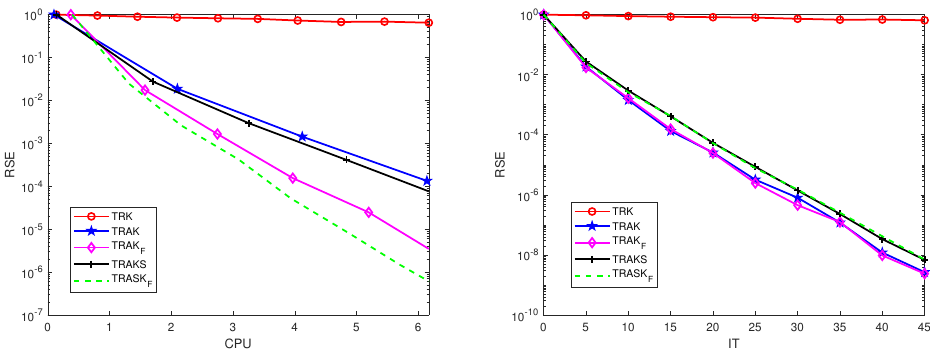
Figure 7. Pictures of the average RSE versus IT and CPU times for the TRK, TRAK, TRAK F , TRAKS, and TRAKS F algorithms when X is the video